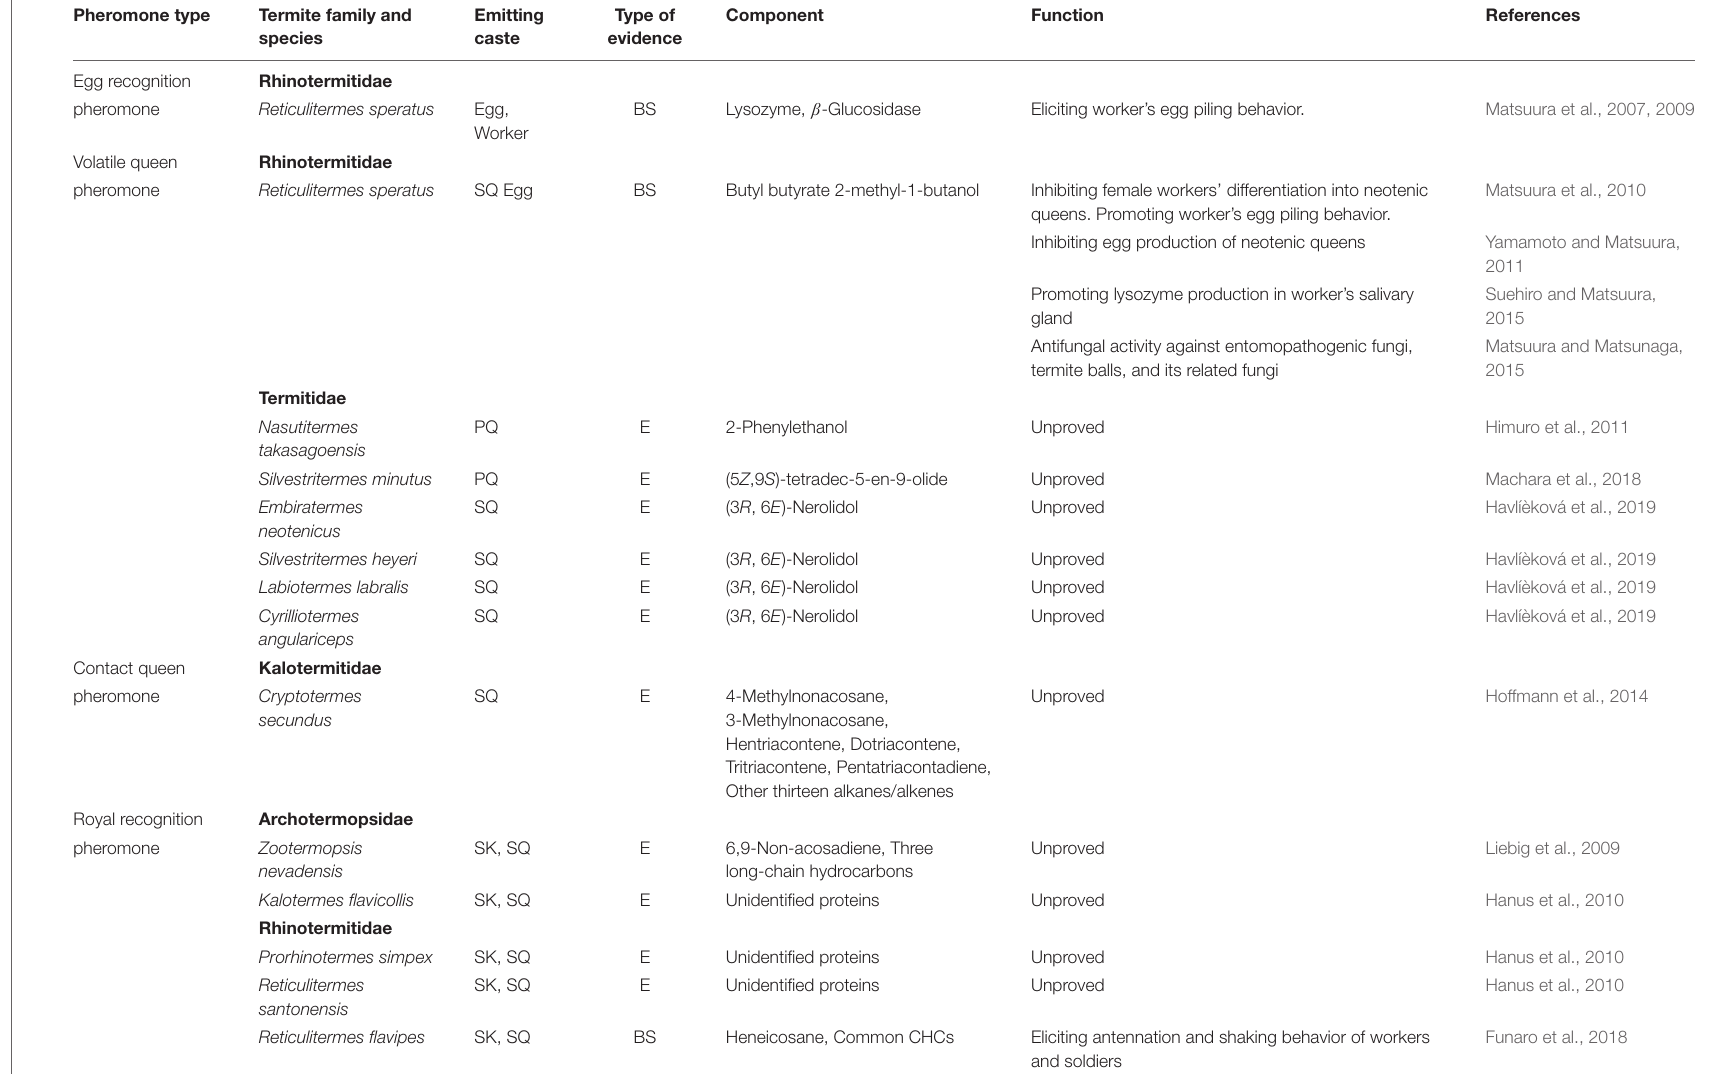
TABLE 4 | List of pheromones involving in